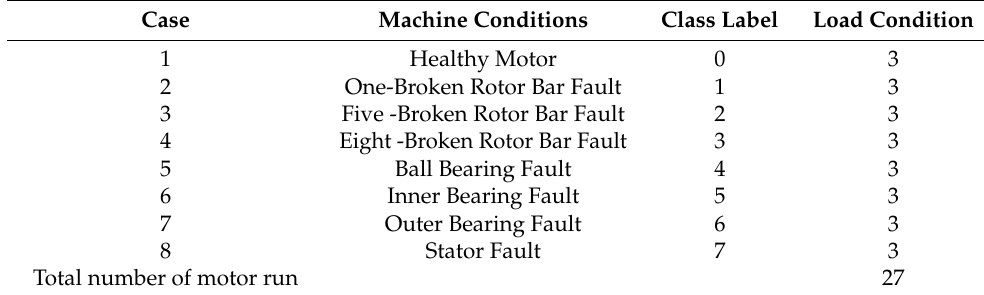
Table 1. Motor condition sets for